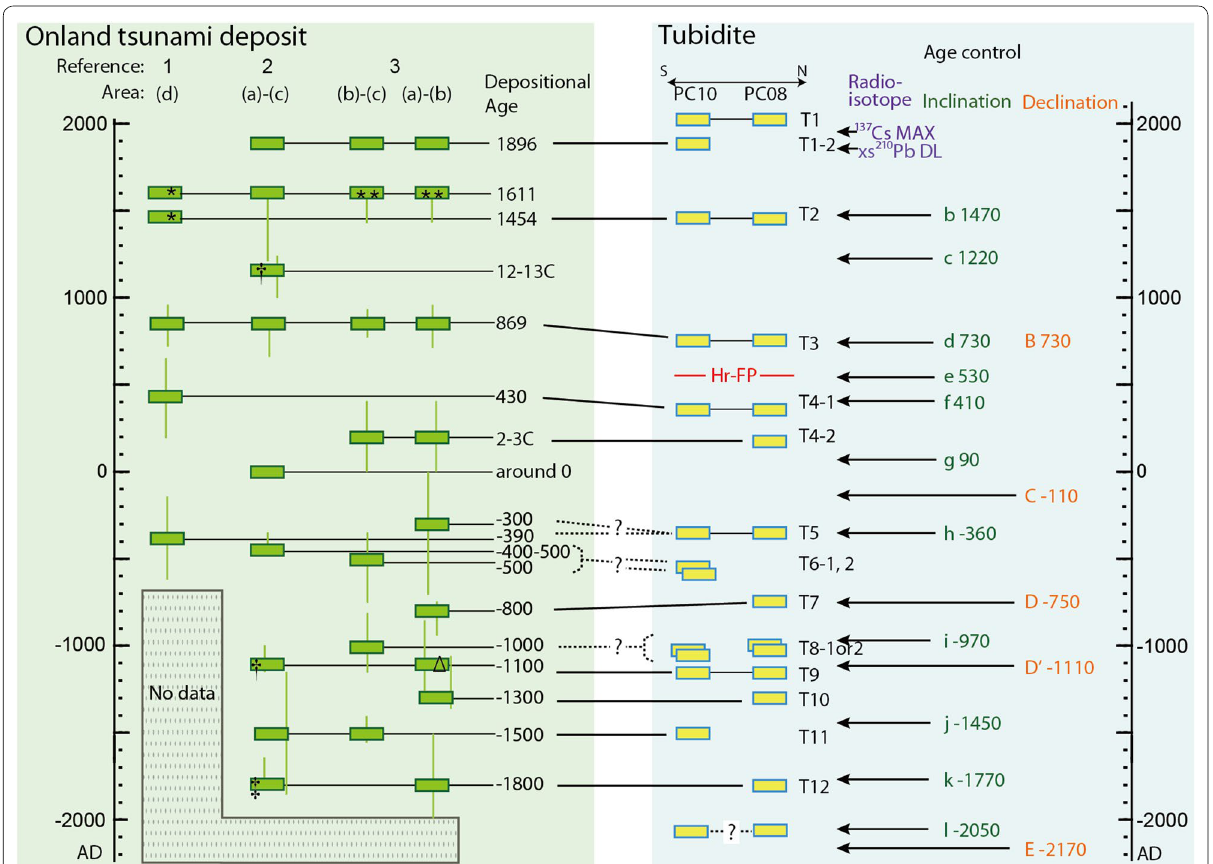
Fig. 3 Stratigraphic correlation between turbidites in the NT13-19 PC08, PC10, and onland tsunami deposits in the Tohoku region during the last 4000 years. References: 1 Sawai et al. 2012; 2 Hirakawa 2012; 3 Takada et al. 2016. Areas (a)–(d) correspond to those in Fig. 1A. *northern part of (d); **possibly the quake of A.D. 1454 (Takada et al. 2016); † (a); ‡ (a) and northern part of (b); Δ: northern part of (a). Estimated depositional age of the tsunami deposits is shown by green rectangles with error bars (2σ) based on results that have smaller margins of error among the values reported in previous studies. The error range of the tsunami deposit around A.D. 0 is unclear. 1896, 1611, 1454, and 869 are the ages of historical earthquakes/ tsunamis. The ages corresponding to PSV labels are from Ali et al.